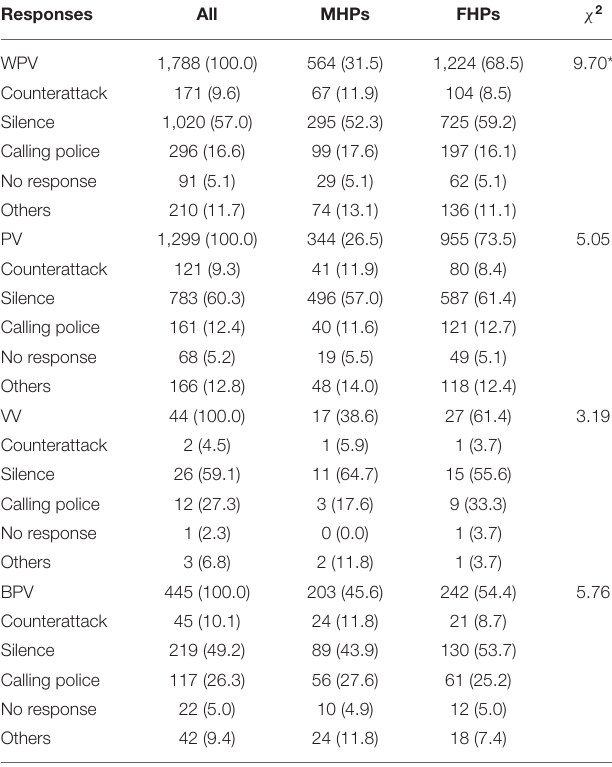
TABLE 3 | Response to different kinds of WPV among MHPs and FHPs experienced workplace violence [ n